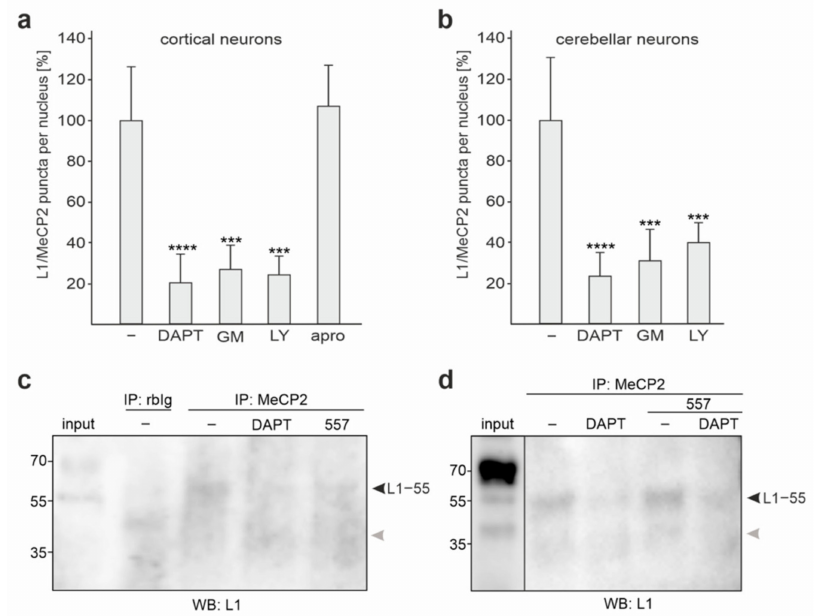
Figure 3. L1 − 55 is generated by α -, β -, and È -secretases. Cultured cortical ( a ) and cerebellar ( b ) neurons were treated with vehicle ( − ) or with the protease inhibitors DAPT, GM60001 (GM), LY2886721 (LY), and aprotinin (apro) and then subjected to proximity ligation with L1 and MeCP2 antibodies. Mean values + SD from three independent experiments analyzing 200–500 cells per condition and experiment are shown for the average numbers of L1/MeCP2-positive red puncta per cell relative to the control (values of treatment with vehicle set to 100%) (*** p < 0.005, **** p < 0.001; one-way ANOVA with Bonferroni multiple comparison test). ( c , d ) Cultured cortical ( c ) and cerebellar ( d ) neurons were treated without or with DAPT and/or L1 antibody 557. Nuclear extracts were isolated from the treated neurons and used for immunoprecipitation (IP) with MeCP2 antibody and non-immune rabbit antibody (rbIg). The immunoprecipitates and the nuclear extracts (input) were subjected to Western blot analysis of the immunoprecipitates with L1 antibody C-2. Bands for L1 − 55 are indicated by black arrowheads. It is noted that a band of ~40 kDa was occasionally seen in in the L1 immunoprecipitates and nuclear extracts. This band is indicated by grey